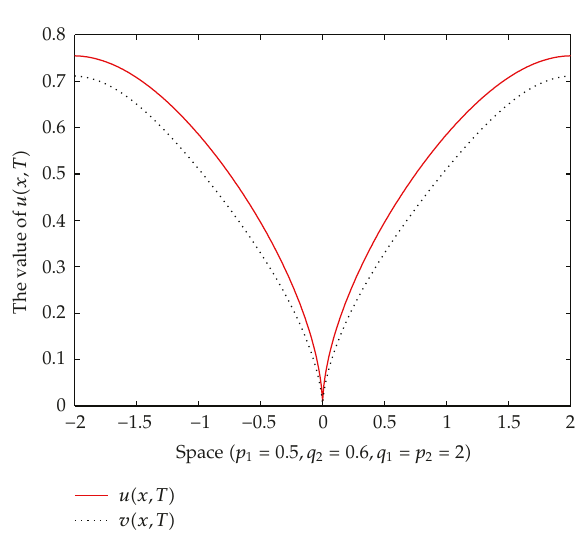
Figure 1: The value of the solution at the quenching time T (cid:3) 0 . 132431.